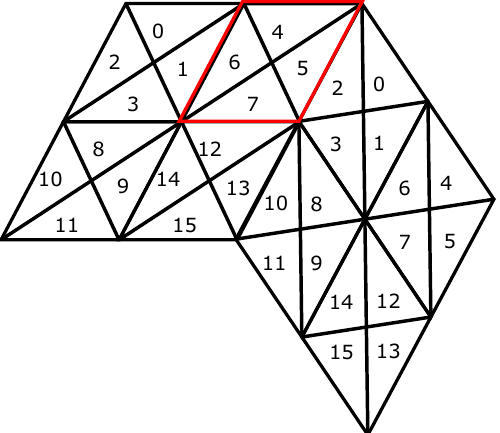
Figure 11. Cell indices of two adjacent base rhombuses. Notice that for any cell c in the small rhombus indicated in red, two neighbours are at indices c ⊕ 1 and c ⊕ 2. This is true of any index in any small rhombus. The final neighbour depends on if we are on a boundary between rhombuses or